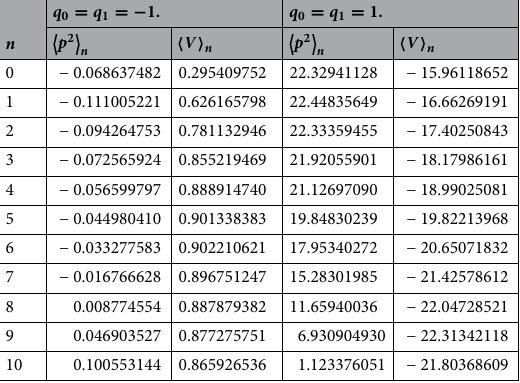
Table 3. Expectation values at various quantum states with (cid:31) = µ = 1, r e = 0.4, α = 0.25 and D e = 5 .